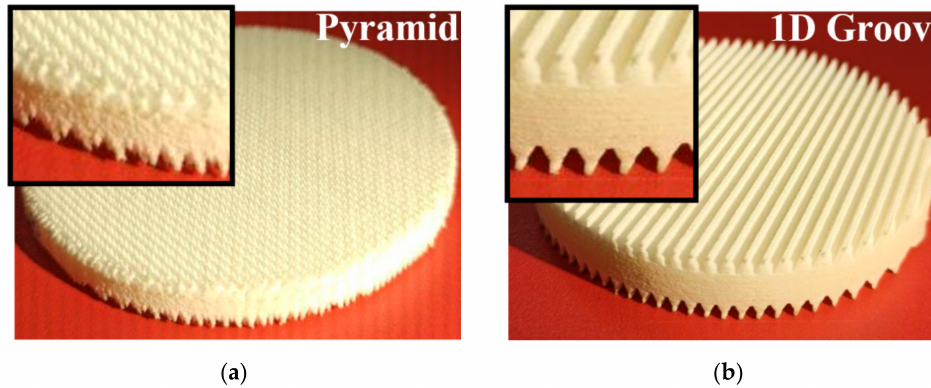
Figure 3. 3D-printed windows with ( a ) pyramids; ( b ) one-dimensional grating of special shape. Three discs were printed: the first one had a flat surface on both sides, the other two had gratings of the tested shape on both sides. The reflection coefficients were obtained by two measurement setups by a vector network analyzer with a step of 30 MHz in the bands of 75–110 GHz and 130–160 GHz, where the disks with optimized surface shapes calculated reflection minima. The window disks were attached to the output of the corrugated tapers providing the gaussian wave beam flat phase front (Figure 4a). The 0-dB level of the setup was set using the flat mirror closing the end of the taper, and the minimum sensitivity limit was set as the reflection from the open end of the taper.